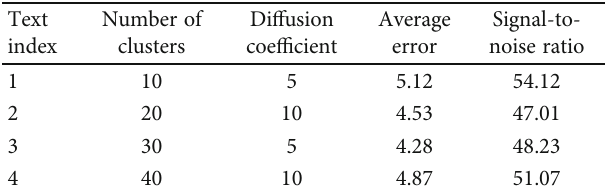
Figure 3: Three-dimensional histogram distribution of network image public opinion similarity under di ff erent thresholds. Table 1: Attributes of online public opinion topic